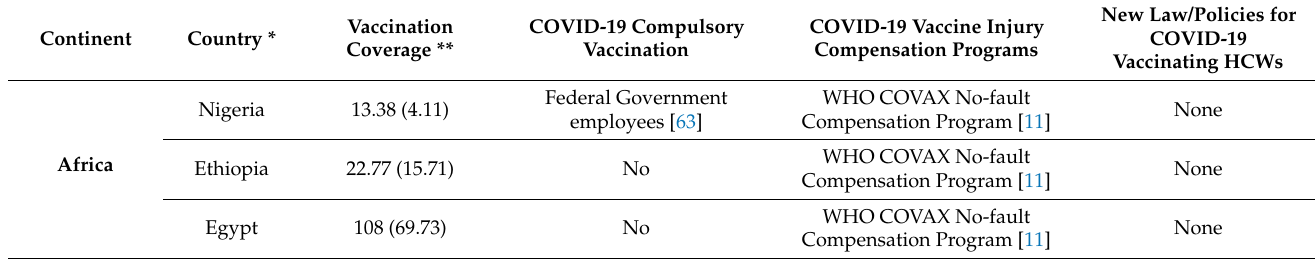
Table 1. COVID-19 vaccination: law and policies, mandatory vaccination, vaccine injury compensa- tion program, and vaccination